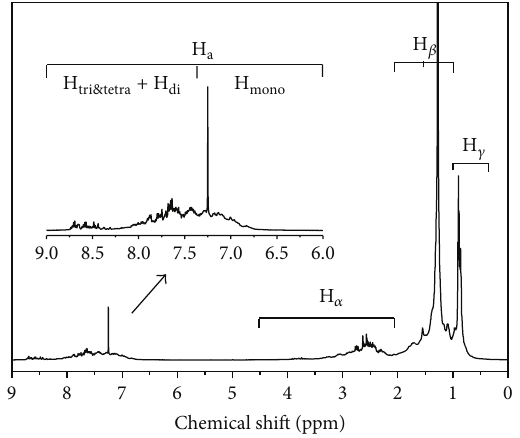
Figure 4: 1 H-NMR spectra of